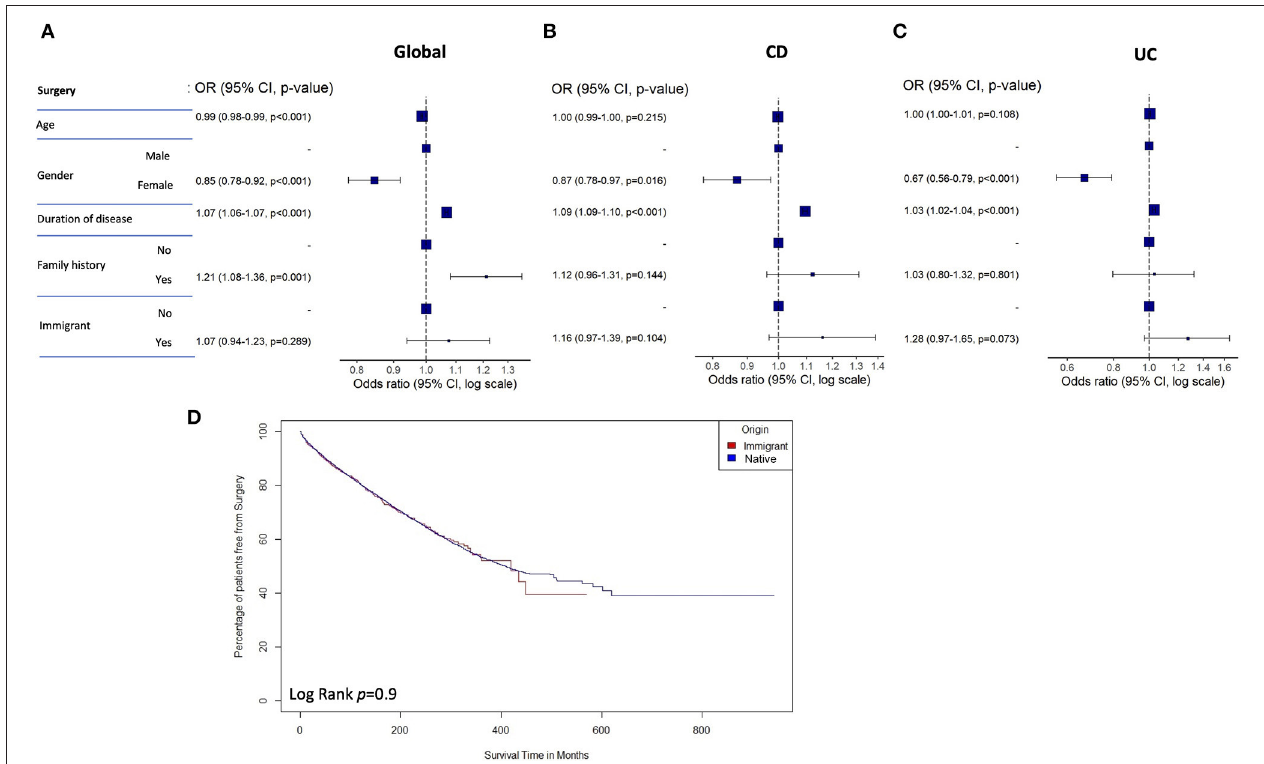
FIGURE 4 | Forest plots representing the odds ratio of surgery in the multivariate analysis for the global (A) , CD (B) , and UC (C) cohorts of patients. (D) Survival analysis of the time to surgery in immigrant vs. native patients. CD, Crohn’s disease; UC, ulcerative colitis.